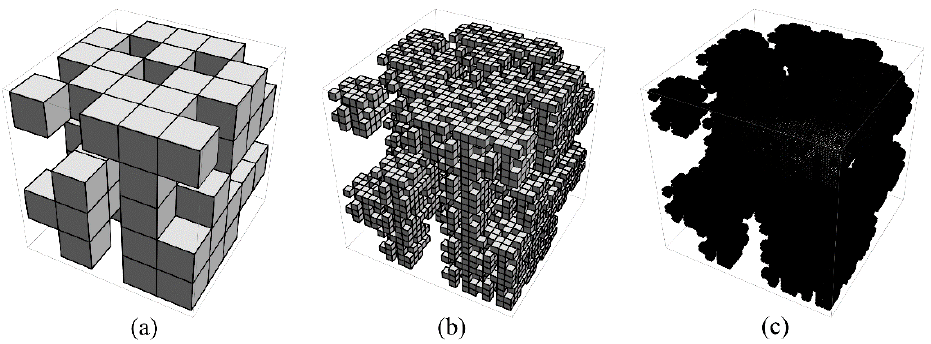
Figure 2. A random configuration of a k -th sub-ubiquitiform with p k = 5, q k = 64, and n k = 3. ( a ) The configuration after the first iteration ( b ) The configuration after the second iteration ( c ) The configuration after the third iteration.